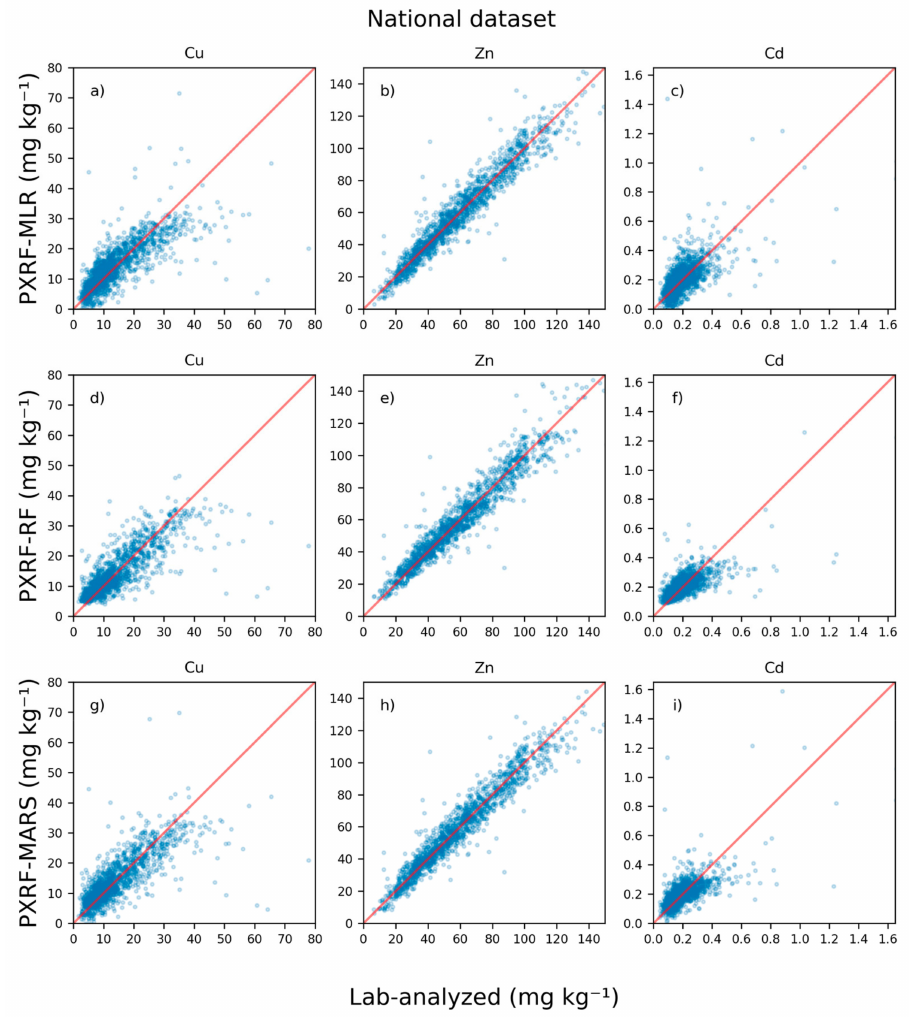
Figure 2. Concentrations of copper (Cu), zinc (Zn), and cadmium (Cd) predicted from portable X-ray fluorescence (PXRF) measurements using multiple linear regression (MLR), random forest regression (RF), and multivariate adaptive regression splines (MARS) for national-scale data using leave-one-out cross-validation compared with 7M HNO 3 extraction and inductively coupled (ICP) analysis. The symbols are semi-transparent to show point